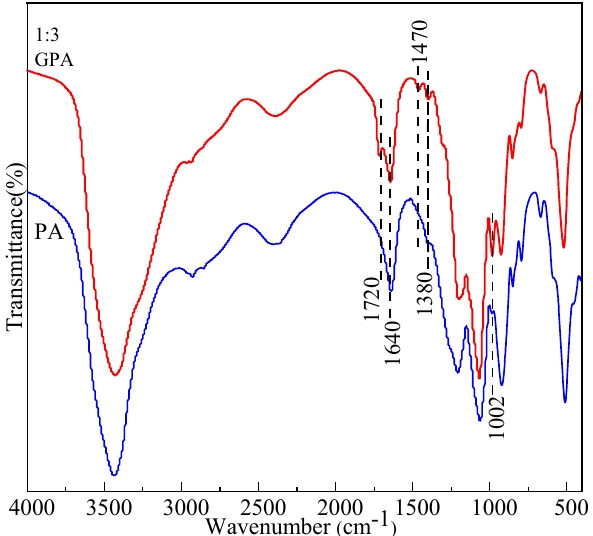
Figure 1. Infrared spectra of the GPA products.